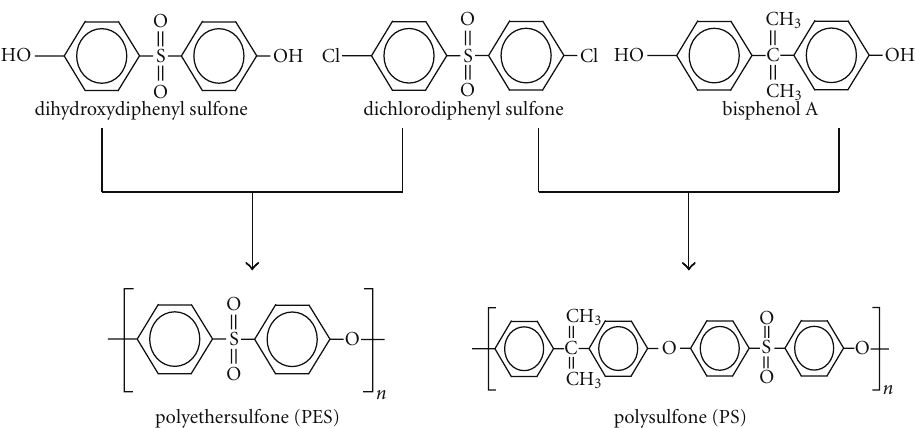
Figure 3: The structural formulas of PES and PS. PS membrane is synthesized by polymerizing dichlorodiphenyl sulfone with bisphenol A, whereas PES is done by polymerizing dichlorodiphenyl sulfone with dihydroxydiphenyl sulfone. Therefore, PES has similar property to PS, but risk of bisphenol A elution from membrane material is lower than that of PS.